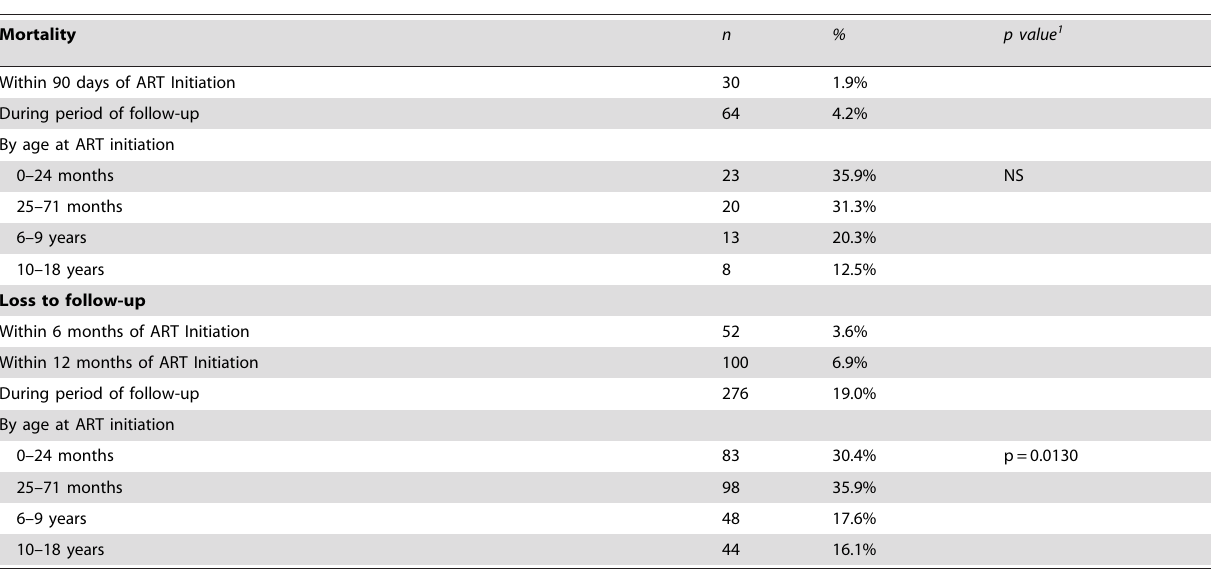
Table 2. Mortality and loss to follow-up by age at ART